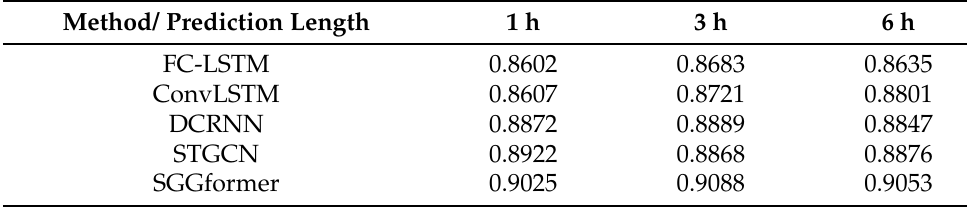
Table 2. Results of comparison with the baselines on accuracy performance.